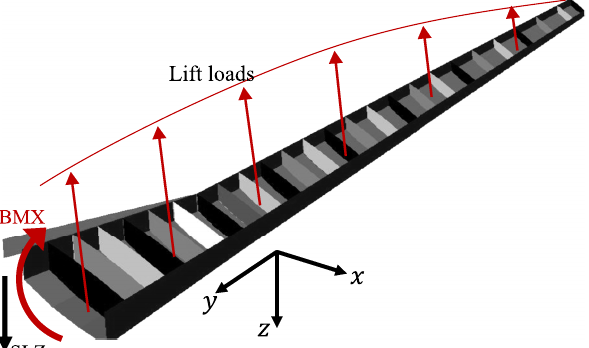
Figure 1. Wing model, coordinate system and idealized loads at the wing root. SLZ: shear load in the z direction. BMX: bending moment about the x direction.